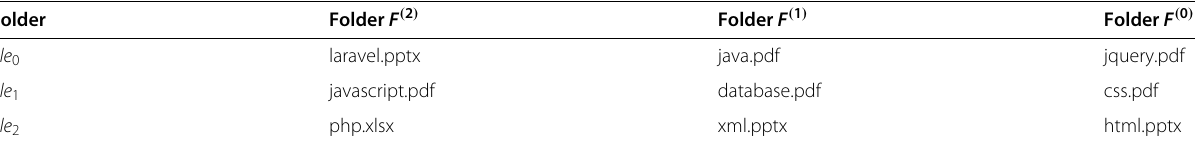
Table 6 Set of files distributed by folder in the cloud environment Google Drive